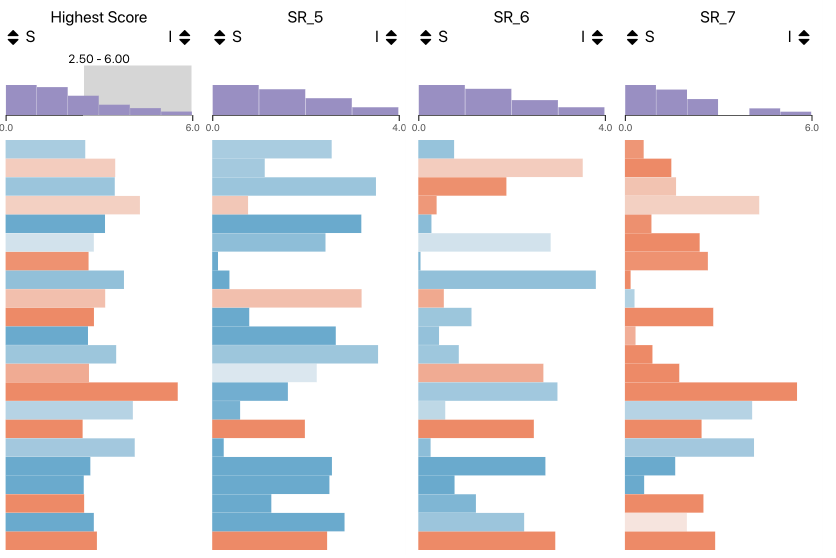
Figure 5. Rows filtered to show only trips with score above 2.5 and until 6. The selection is made on the top of the trip score component (C) using the vertical column bars with a rectangle in dark gray.